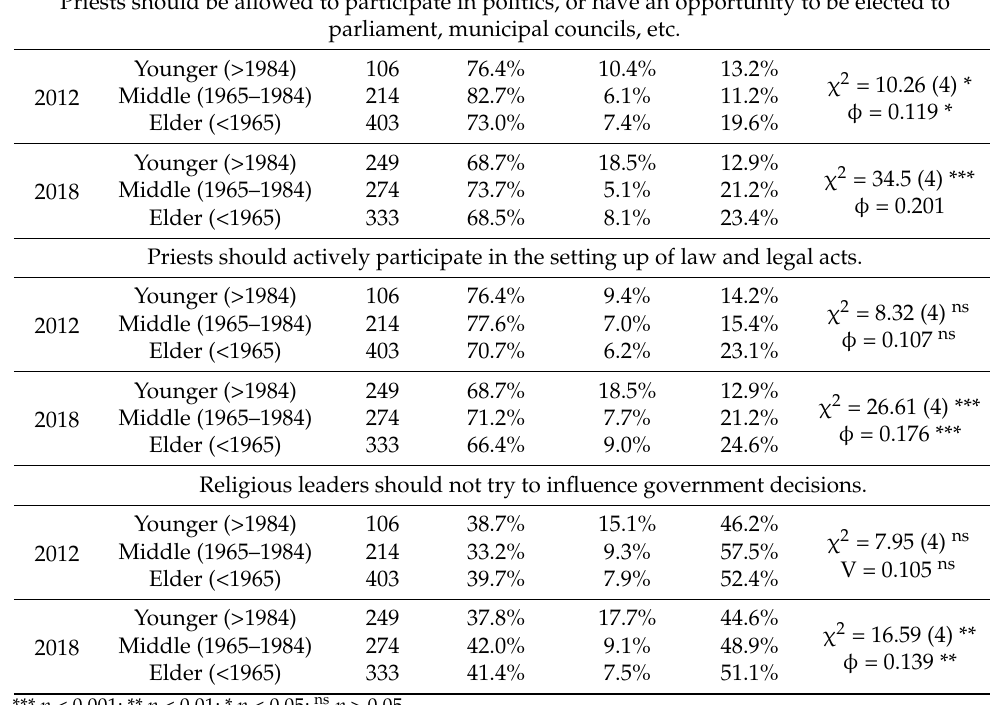
Neither χ 2 (df) N Disagree Agree nor Agree (100%) Cramer’s Disagree